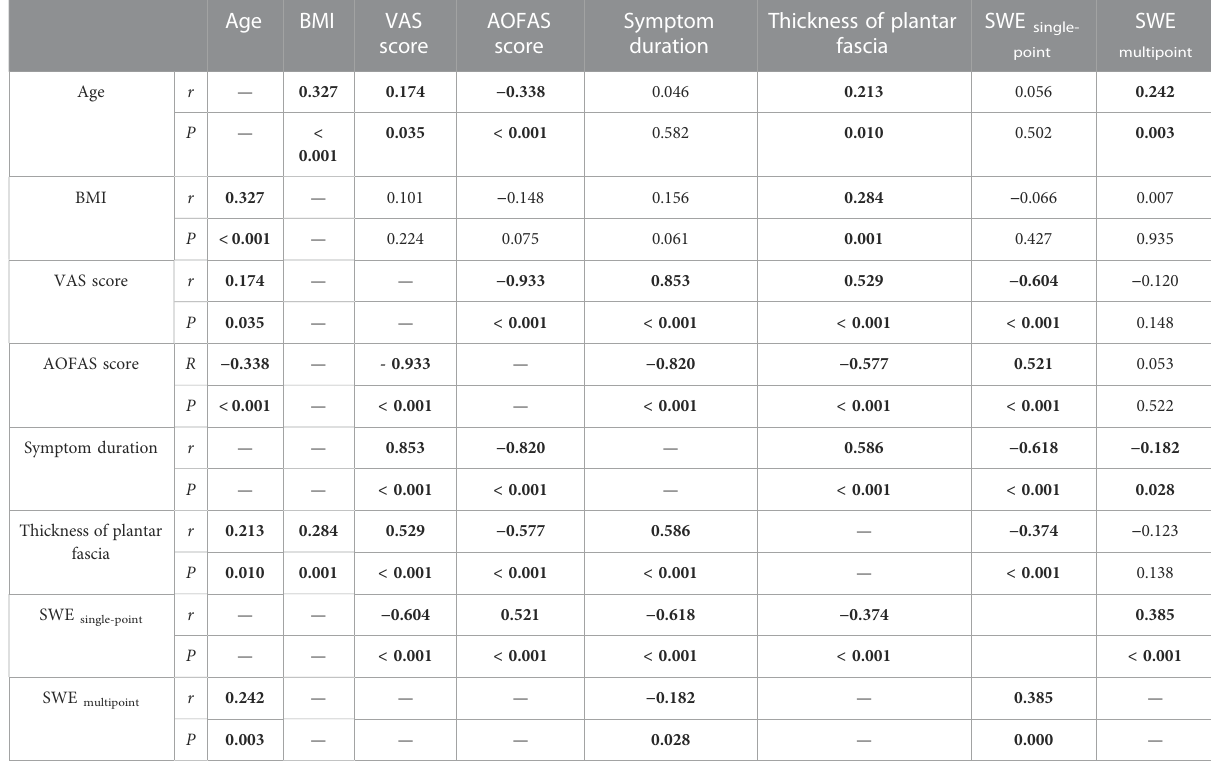
Theupper-rightpartofthetableshowsallcorrelations( r =CC,andP)amongultrasoundparametersandclinicalparametersinthesubjects.Thelower-centerpanelrepresentssigni fi cant correlations( p < 0.05).Boldfontindicatesasigni fi cantcorrelation( p < 0.05).BMI,bodymassindex;VAS,visualanaloguescale;AOFAS,americanorthopedicfootandanklesocietyscore; SWE, shear wave elastography; r, correlation coef fi cient; P, signi fi